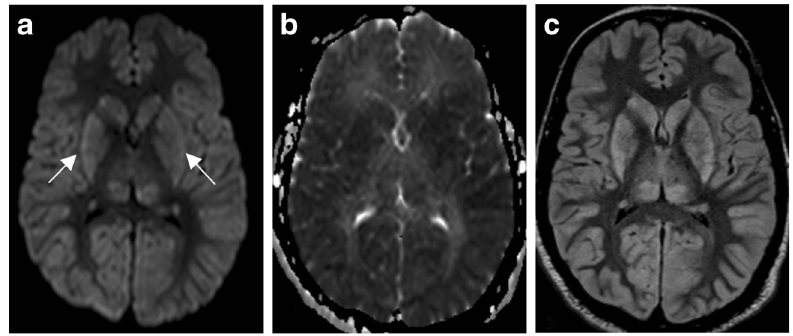
corresponding low signal, consistent with reduced diffusivity. FLAIR ( c ) demonstrates corresponding symmetric increased signal